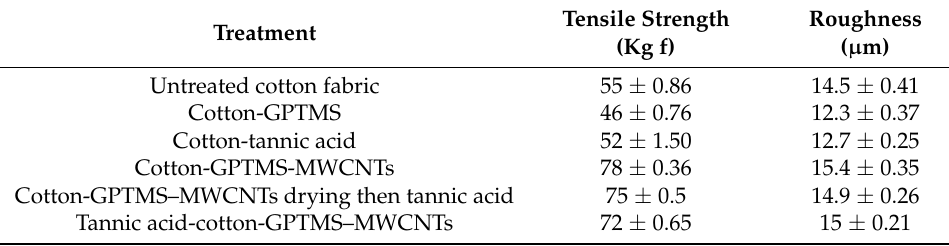
Table 4. Tensile strength and roughness of treated and untreated cotton